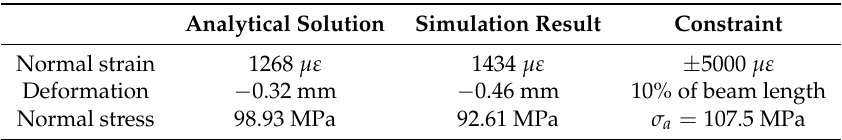
Table 2. Results of the analysis of sensor prototype